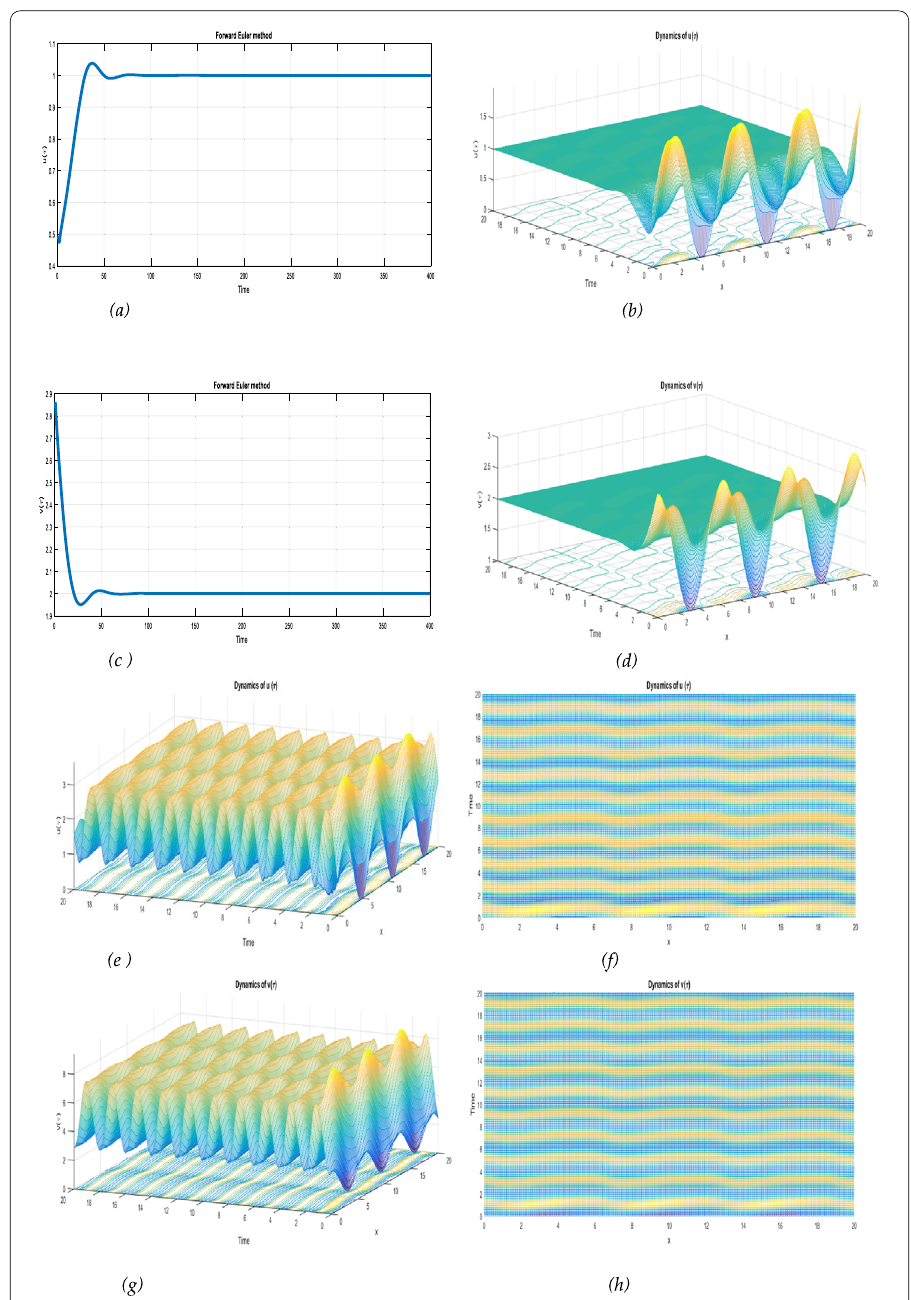
Figure 1 ( a )–( d ) Numerical solutions of system (32) using forward Euler scheme. Here, u 0 = 1 + sin( x ) and v 0 = 2 + cos( x ), with l = 5, m = 1, κ 1 = 0.01, and κ 2 = 0.01. The concentration of u ( τ ) is at the top (2D and 3D plots) while the concentration of v ( τ ) is at the bottom (2D and 3D plots). The solutions v ( x , τ ) and u ( x , τ ) tend to the constant steady state. ( e )–( h ) Numerical solutions of system (32) using forward Euler scheme. Here, u 0 = 1 + sin( x ) and v 0 = 2 + cos( x ), with l = 10, m = 5, κ 1 = 0.01, and κ 2 = 0.01. (Top) The solutions v ( x , τ ) and u ( x , τ ) tend to the spatially homogeneous periodic orbit. (Bottom) The projected views onto the x τ -plane at τ = 20 for v ( x , τ ) and u ( x , τ ). The stripe structure invades the homogeneous periodic orbit for v ( x , τ ) and u ( x , τ